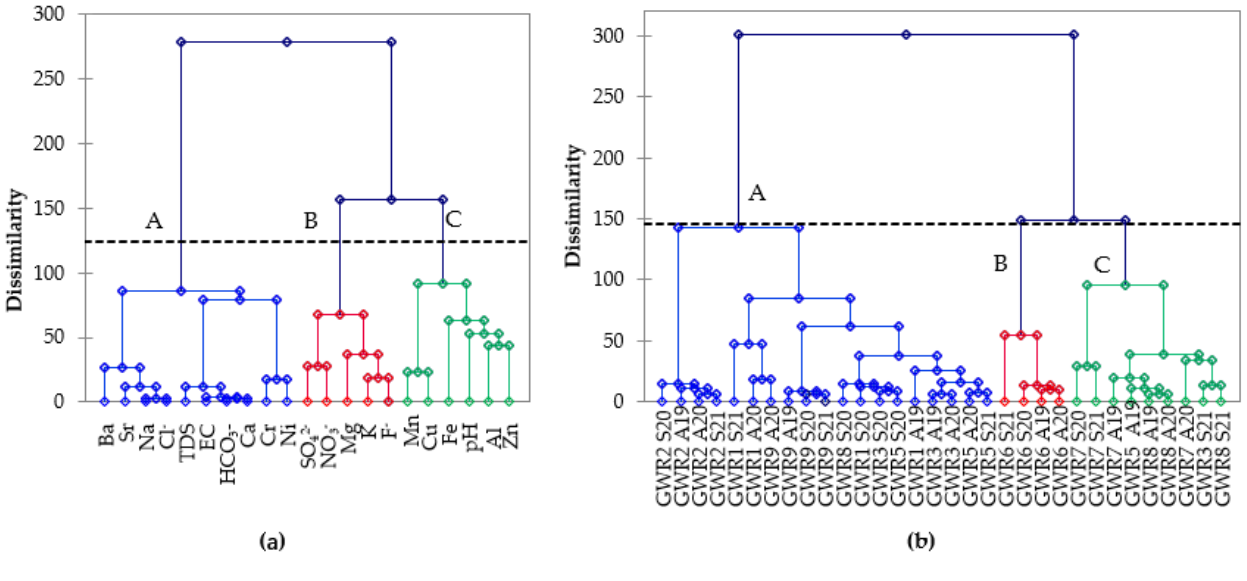
Figure 4. Hierarchical clustering of physico-chemical parameters in spring waters ( a ) and the studied spring samples ( b ).